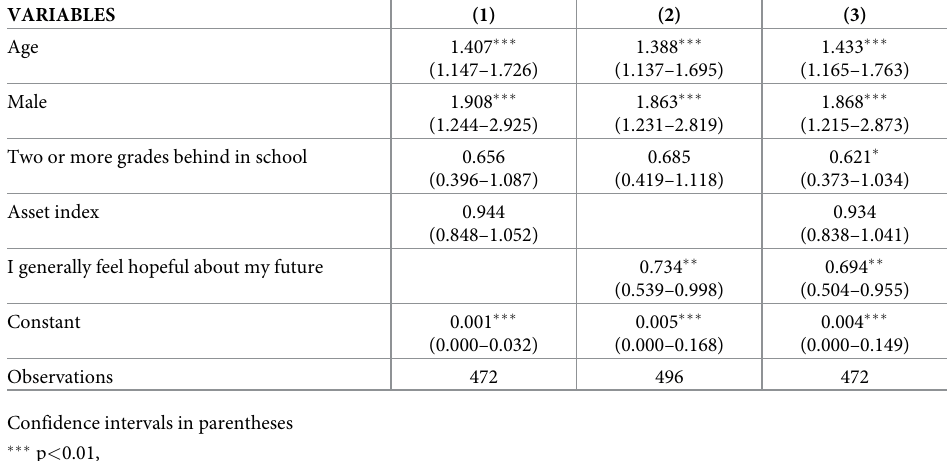
Table 7. Alcohol use: Logit regressions including hope, assets, and hope and assets, odds ratios reported.